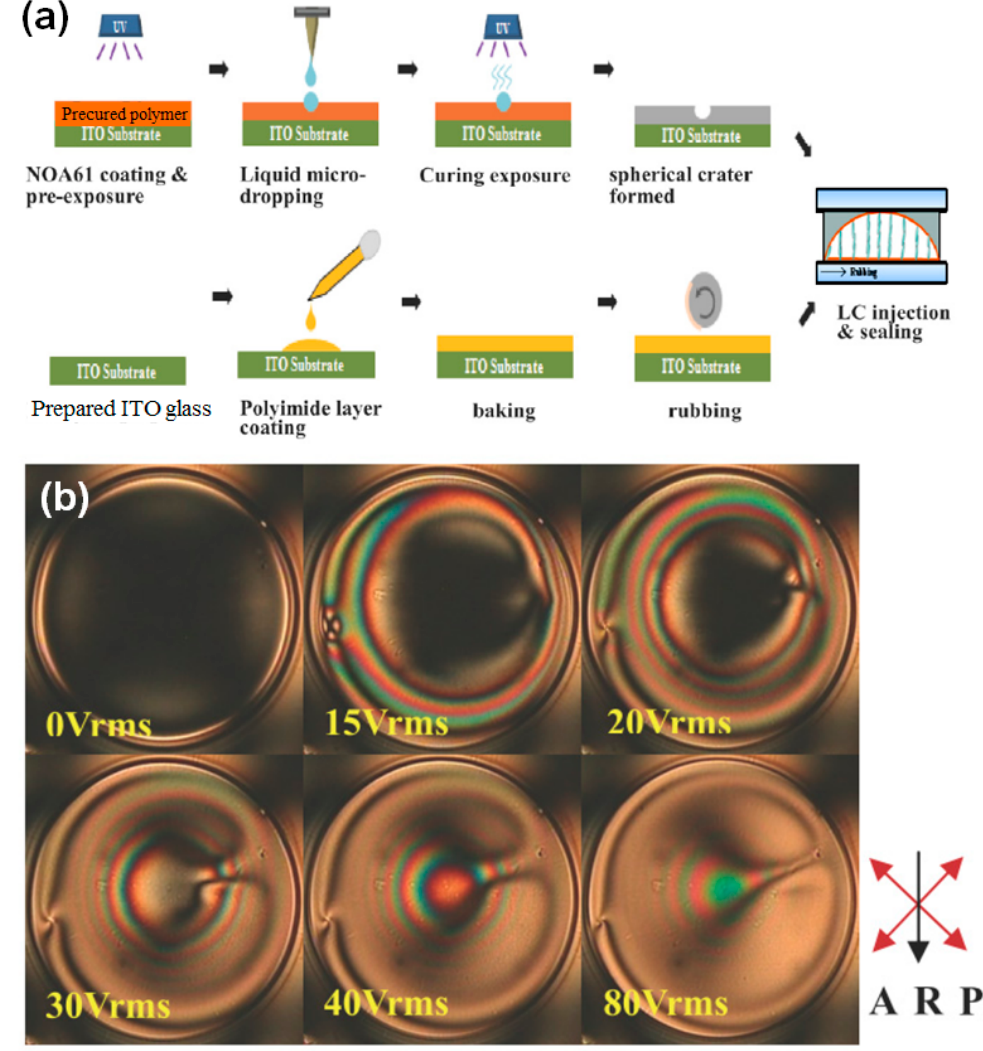
Figure 7. ( a ) Schematic diagram of the steps in the preparation of a liquid crystal microlens. ( b ) Polarized optical microscopy images of the liquid crystal microlens under various applied voltages. R: Rubbing direction; A: Orientation of analyzer; P: Orientation of cross polarizer [29]. Copyright 2013 Optical Society of America.